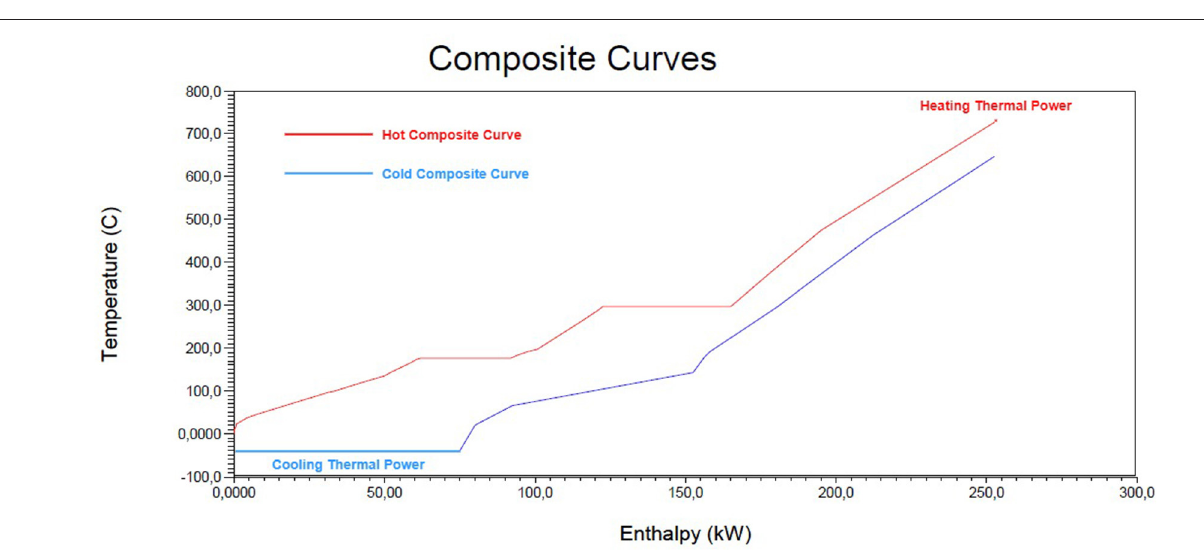
FIGURE 7 | Composite Curves of the process stream for Case